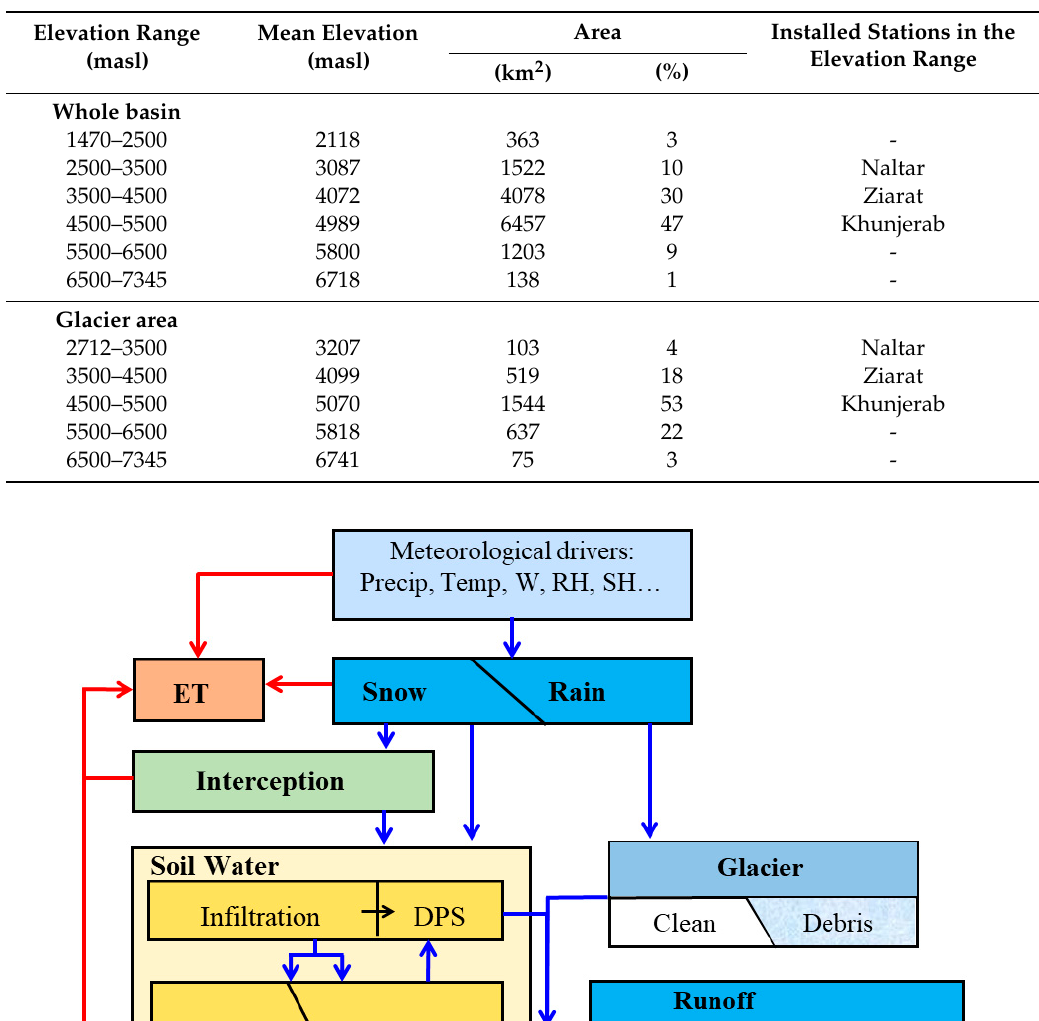
Table 1. Hypsometry of the Hunza basin.